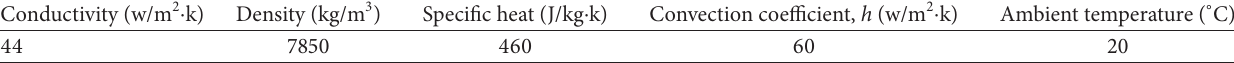
Figure 12: Improved CFD; (a) cylinder, (b) shaft, and (c) assembled CFD. Table 3: Thermal characteristics of the numerical